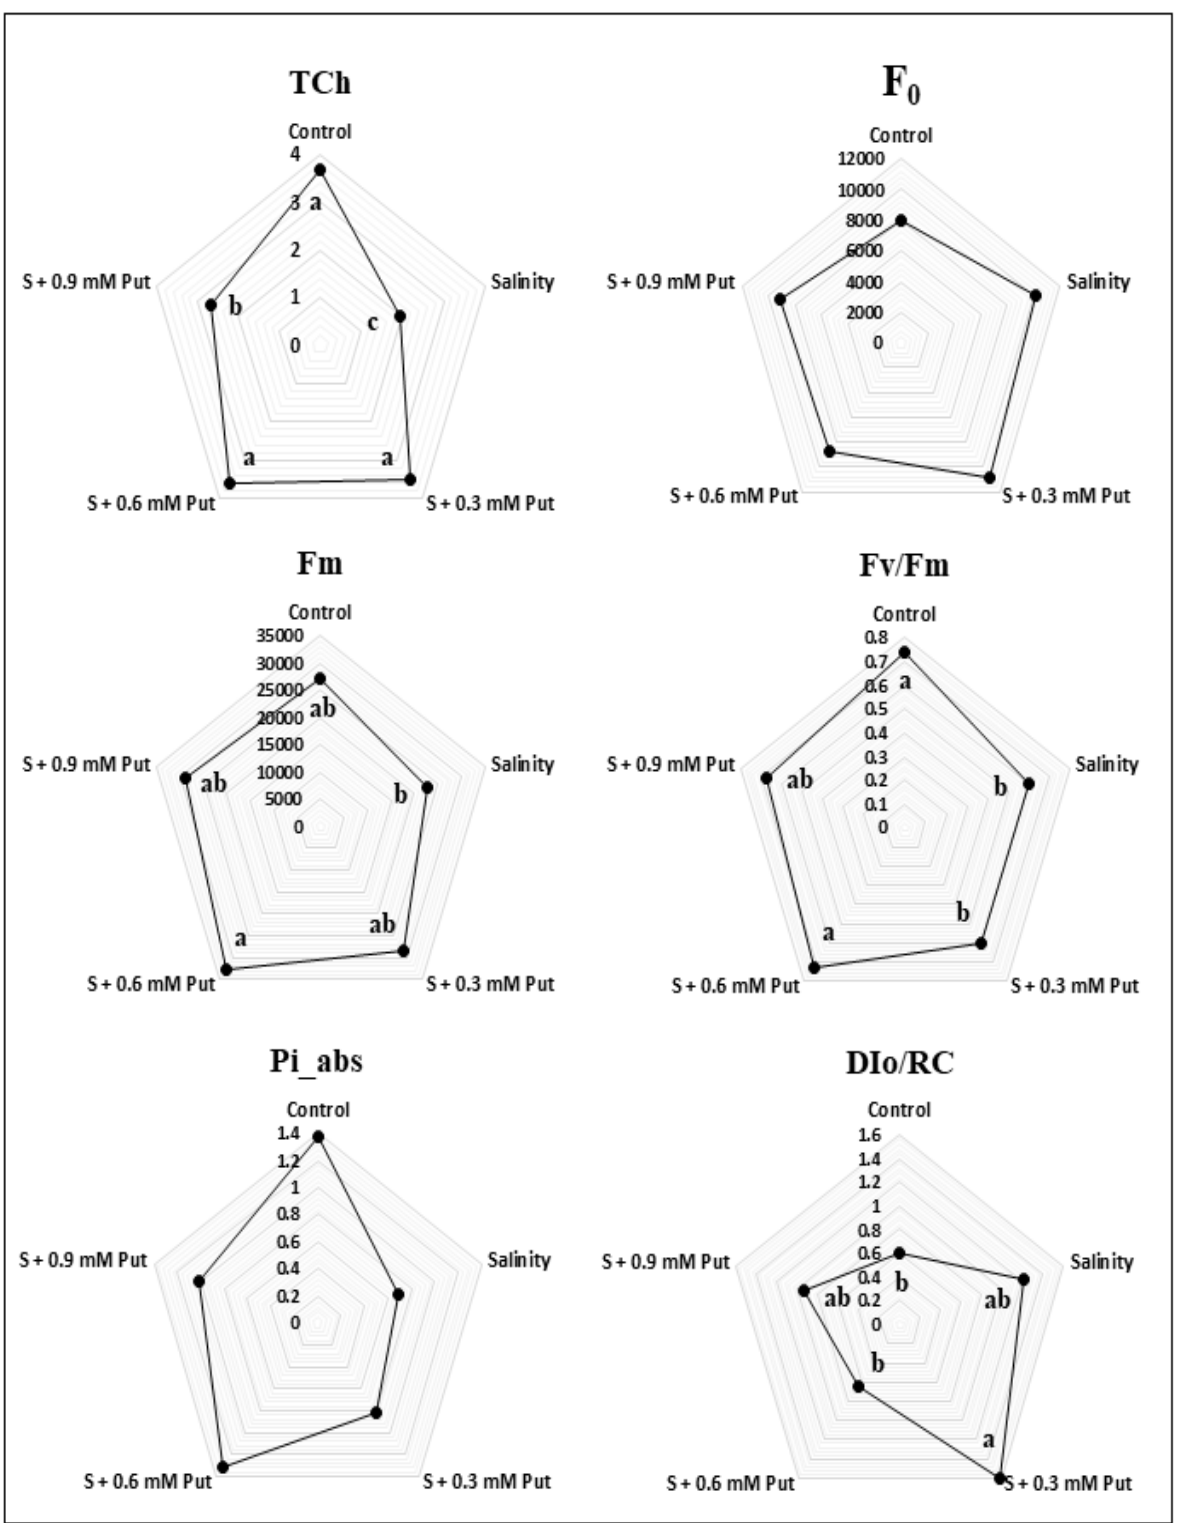
Figure 1 . Effect of foliar application of putrescine on fluorescence intensity at 50 µs (F 0 ), maximal fluorescence intensity (F m ), maximum photosynthetic quantum yield (Fv/Fm), calculated PSII performance index (Pi_abs), and dissipated energy flux (DI 0 /RC), of ginseng seedlings grown under salinity stress condition.